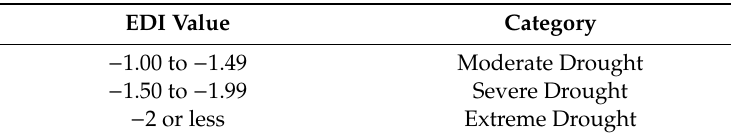
Table 2. Drought classification based on severity [26].